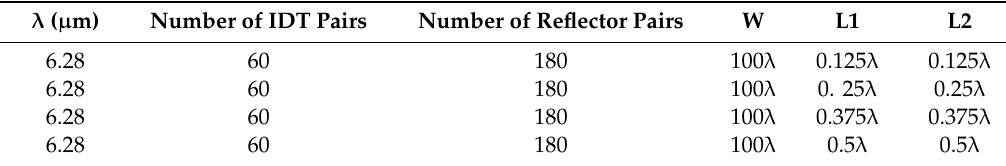
Table 3. One-port SAW resonator design parameters.